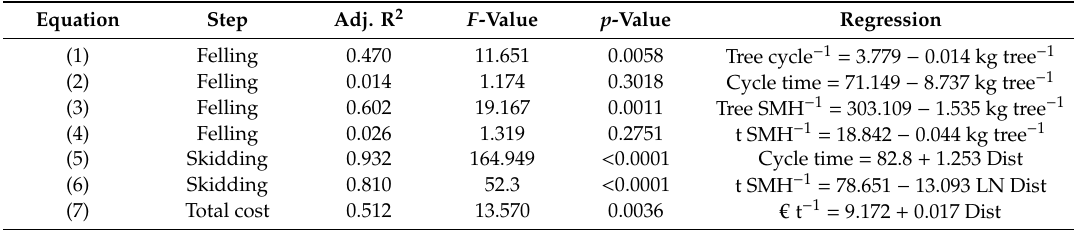
Table 3. Main results of the regression